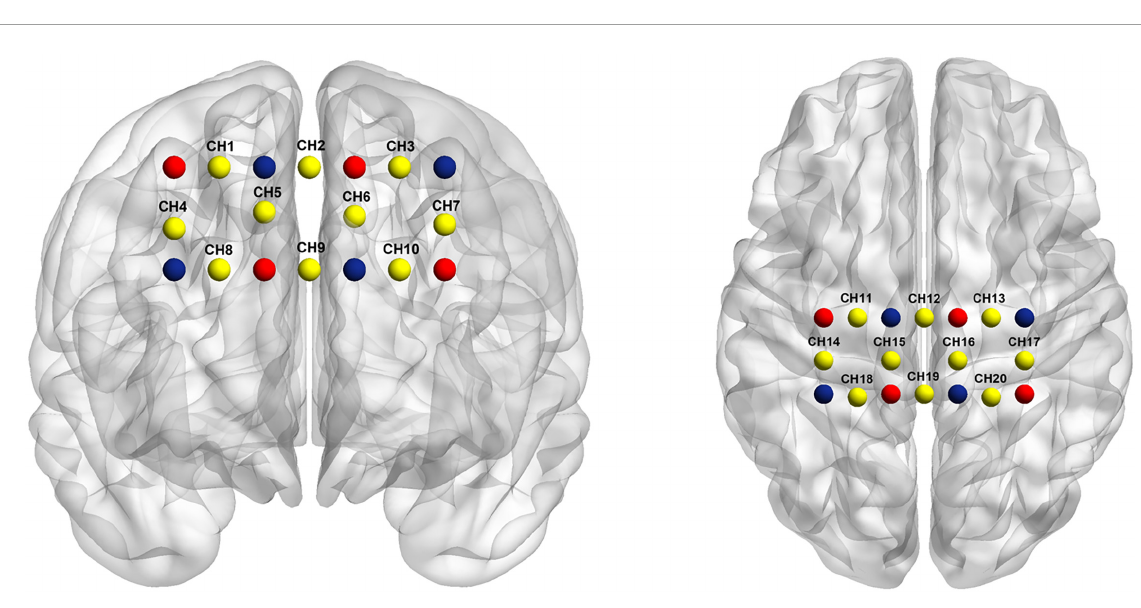
FIGURE5 Optode probe set. The dorsolateral prefrontal cortex (DLPFC) (channels 1–7), primary motor cortex (channels 10–17), and primary somatosensory cortex (channels 18–20). Channels (in yellow) are measured between emitters (in red) and detectors (in blue).